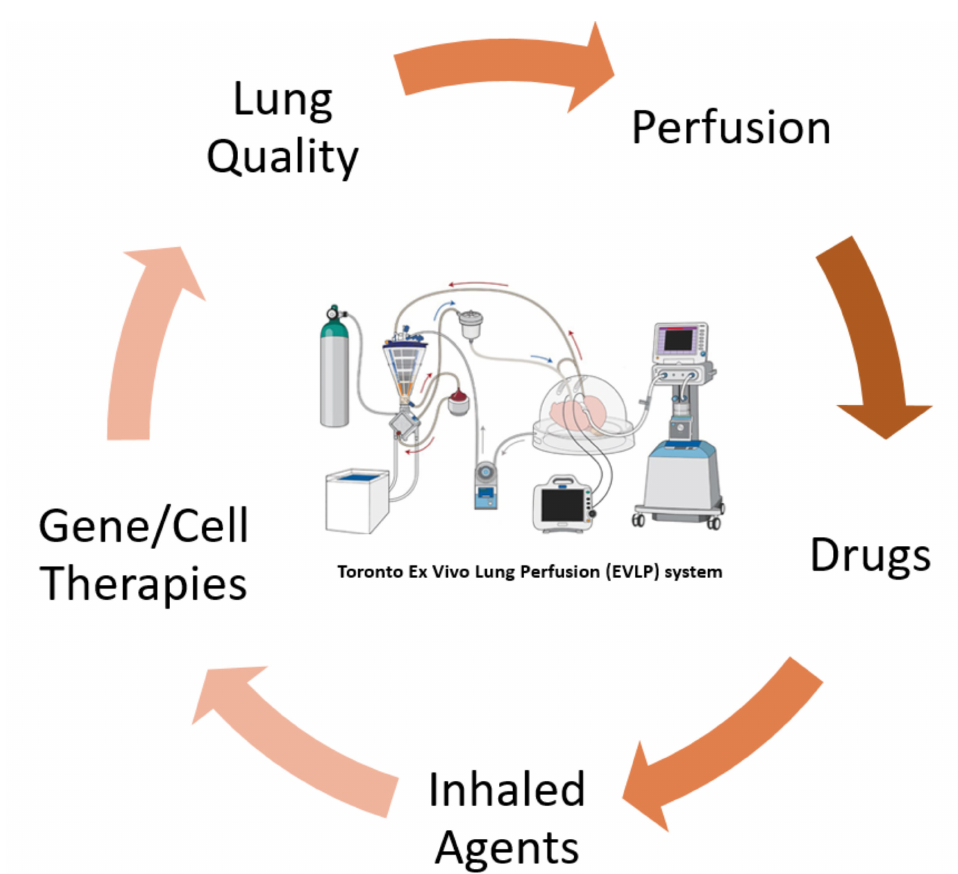
Figure 4. Concept illustration of the normothermic ex vivo lung perfusion (EVLP) platform and opportunities for treatment strategies. Adapted from